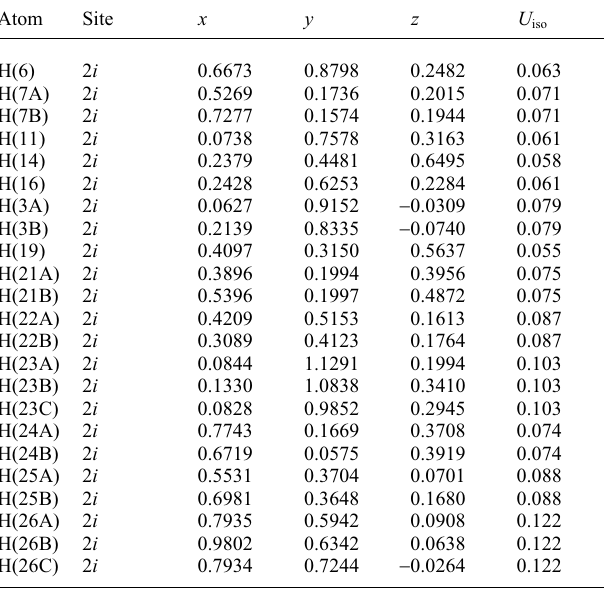
Table 2. Atomic coordinates and displacement parameters (in Å 2 )